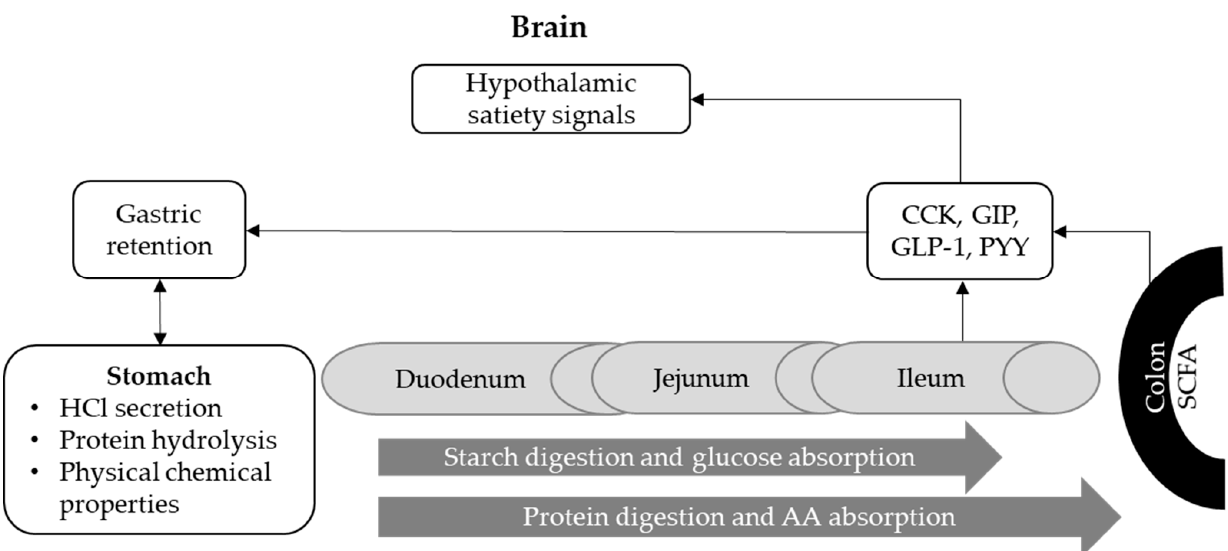
Figure 4. Interactions between the passage rate of digesta and feed intake. AA = amino acids, CCK = cholecystokinin, GLP ‐ 1 = glucagon ‐ like peptide 1, GIP = glucose ‐ dependent insulinotropic polypeptide, HCl = hydrochloric acid, PYY = peptide YY, SCFA = short ‐ chain fatty acids. The figure is adapted from Giger ‐ Reverdin et al. [152] and Lee et al. [167].